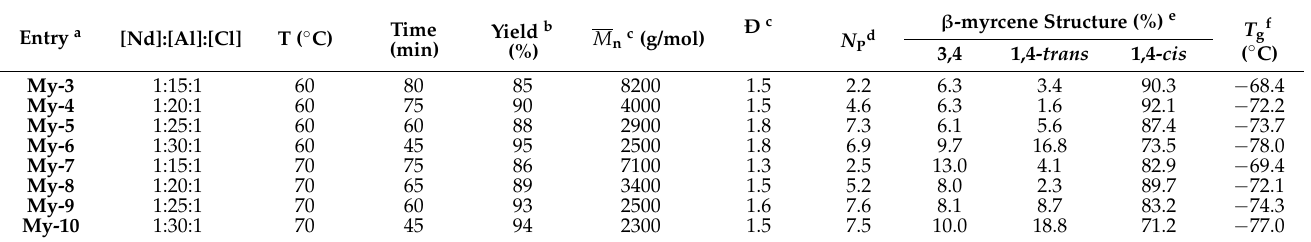
Table 3. Myrcene polymerization initiated by NdV 3 /Al( i -Bu) 2 H/Me 2 SiCl 2 in cyclohexane under different reaction